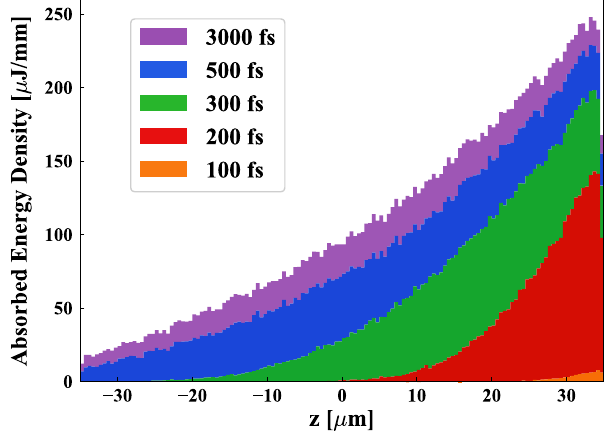
FIG. 7. Absorbed energy density along the thickness at differ- ent